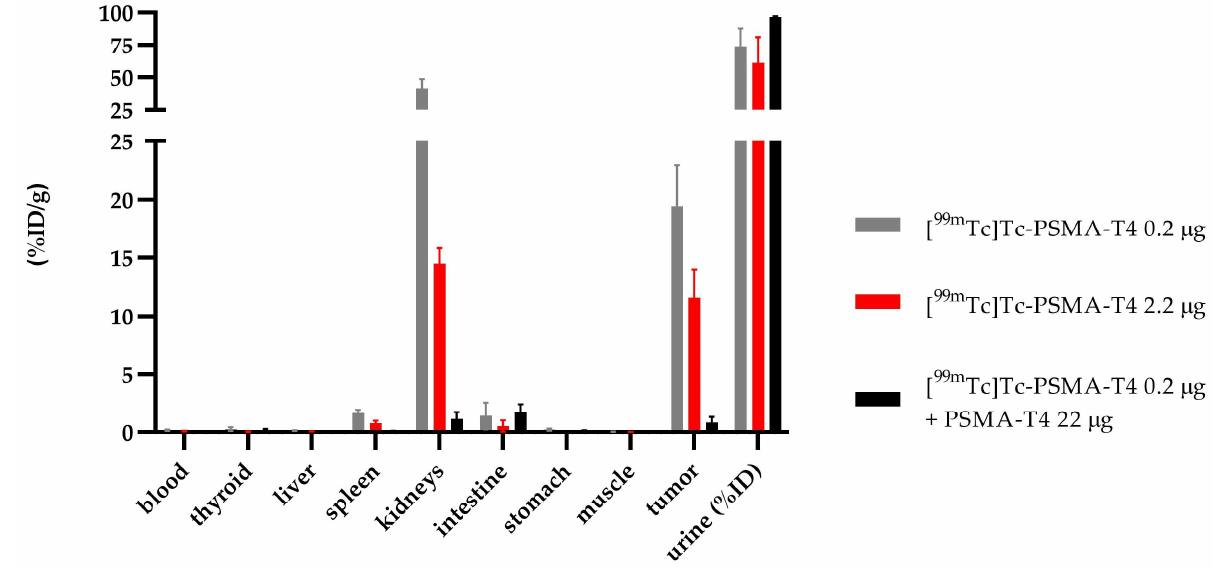
Figure 7. Biodistribution of [ 99m Tc]Tc-PSMA-T4 in BALB/c Nude injected in two doses of radiolabeled PSMA-T4 (0.22 µg and 2.2 µg, gray and red bar, respectively) and as co-injection with an excess of unlabeled PSMA (black bar).